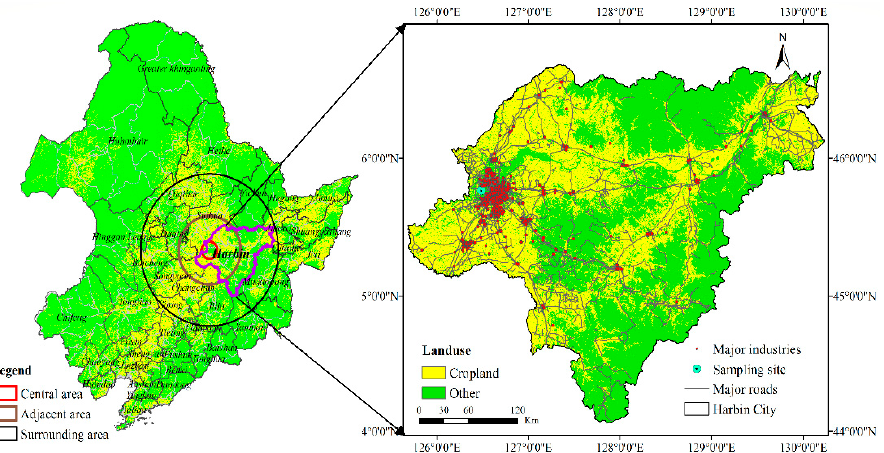
Figure 1. Study region in northeastern China and its farmland distribution. Light-yellow area represents the farmland distribution of northeastern China. Black and fuchsia boundaries on the left indicate Northeastern China and Harbin city; the red points on the right are major industries of Harbin.